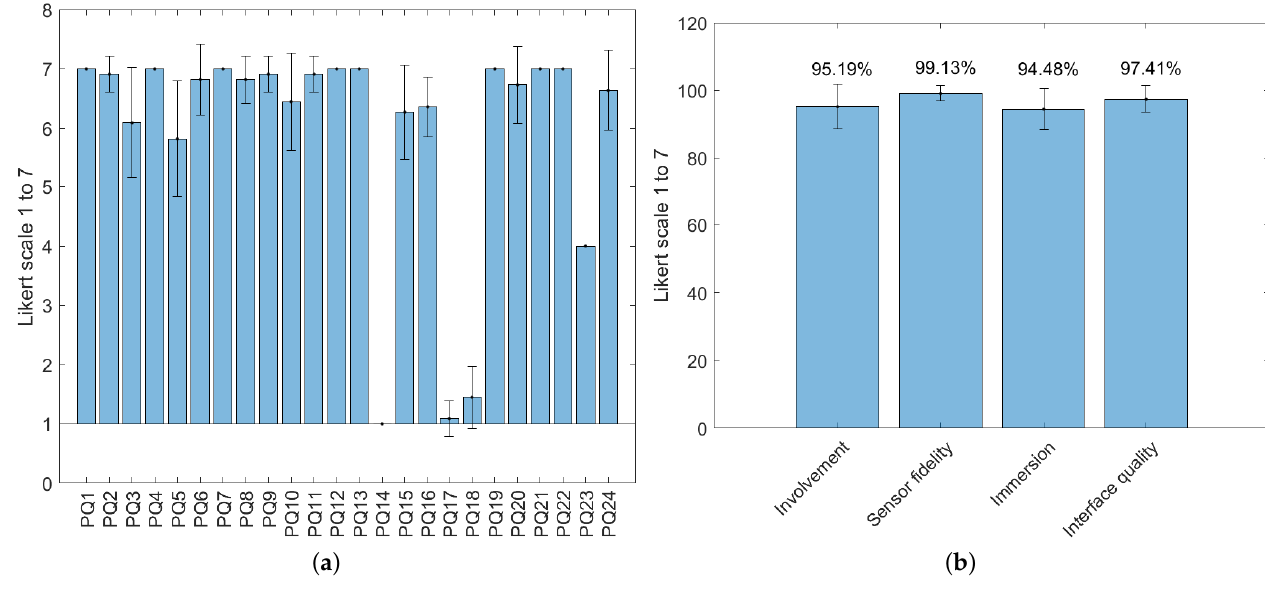
Figure 10. Results of the presence questionnaire. ( a ) Mean and standard deviation per question. ( b ) Subscale results (mean and standard